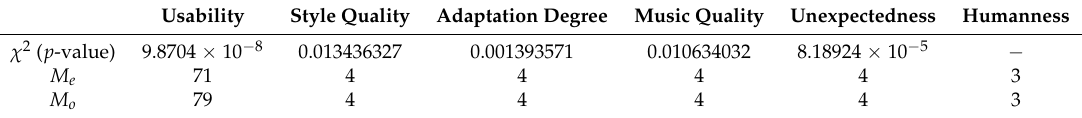
Table 2. Shows the final statistics when the users finished testing the